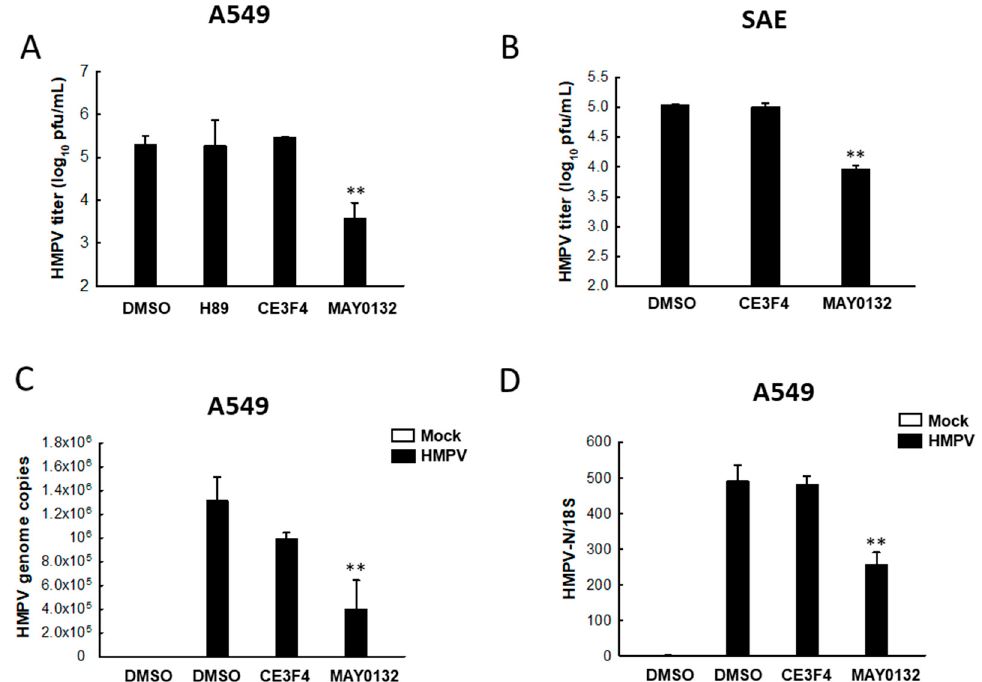
Figure 1. The impact of EPAC2 on HMPV replication. ( A , B ) A549 ( A ) or SAE ( B ) cells in triplicate were infected with HMPV at an MOI of 1. At 2 h post-infection (p.i.), cells were washed and subsequently treated with 20 µ M CE3F4 or MAY0132. Next, 20 µ M H89 was used to examine the role of cAMP/PKA signaling in HMPV infection. DMSO was used as vehicle control for EPAC inhibitors. At 15 h post-treatment, total viruses were harvested, and viral titer was determined by immunostaining using an anti-HMPV antibody. Data are representative of three independent experiments. ** p < 0.01, relative to the DMSO-treated group. ( C , D ) A549 cells in triplicate were infected with HMPV, followed by drug treatment as described in ( A ). After 15 h post-treatment, total RNA was extracted and subjected to qRT-PCR to measure HMPV genome copies ( C ) and N gene expression ( D ). 18S ribosomal RNA (rRNA) was used for normalization to N gene level. DMSO-treated mock infection was used as a negative control for DMSO-treated HMPV infection. ** p < 0.01, relative to the DMSO-treated and HMPV-infected group.